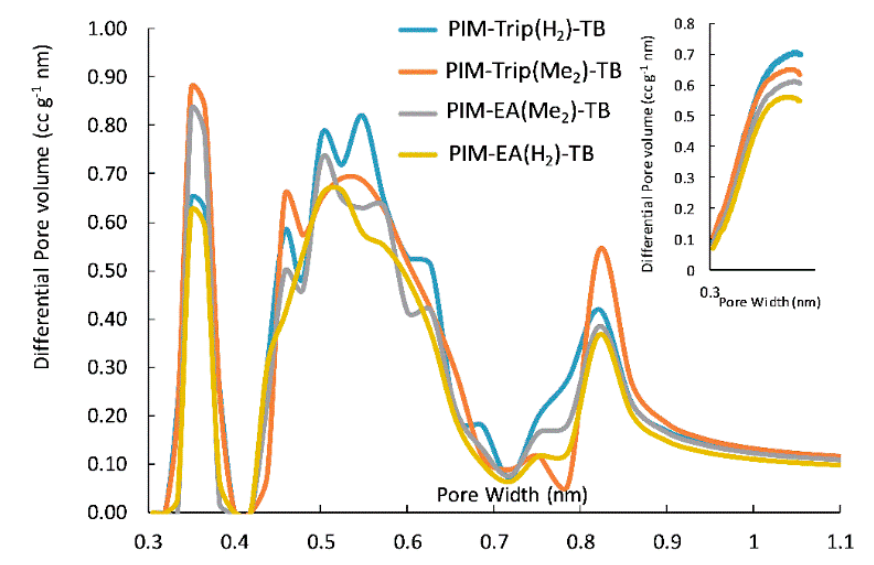
Figure 3. NLDFT and H-K (inset) model PSD measured from CO 2 at 273 K.